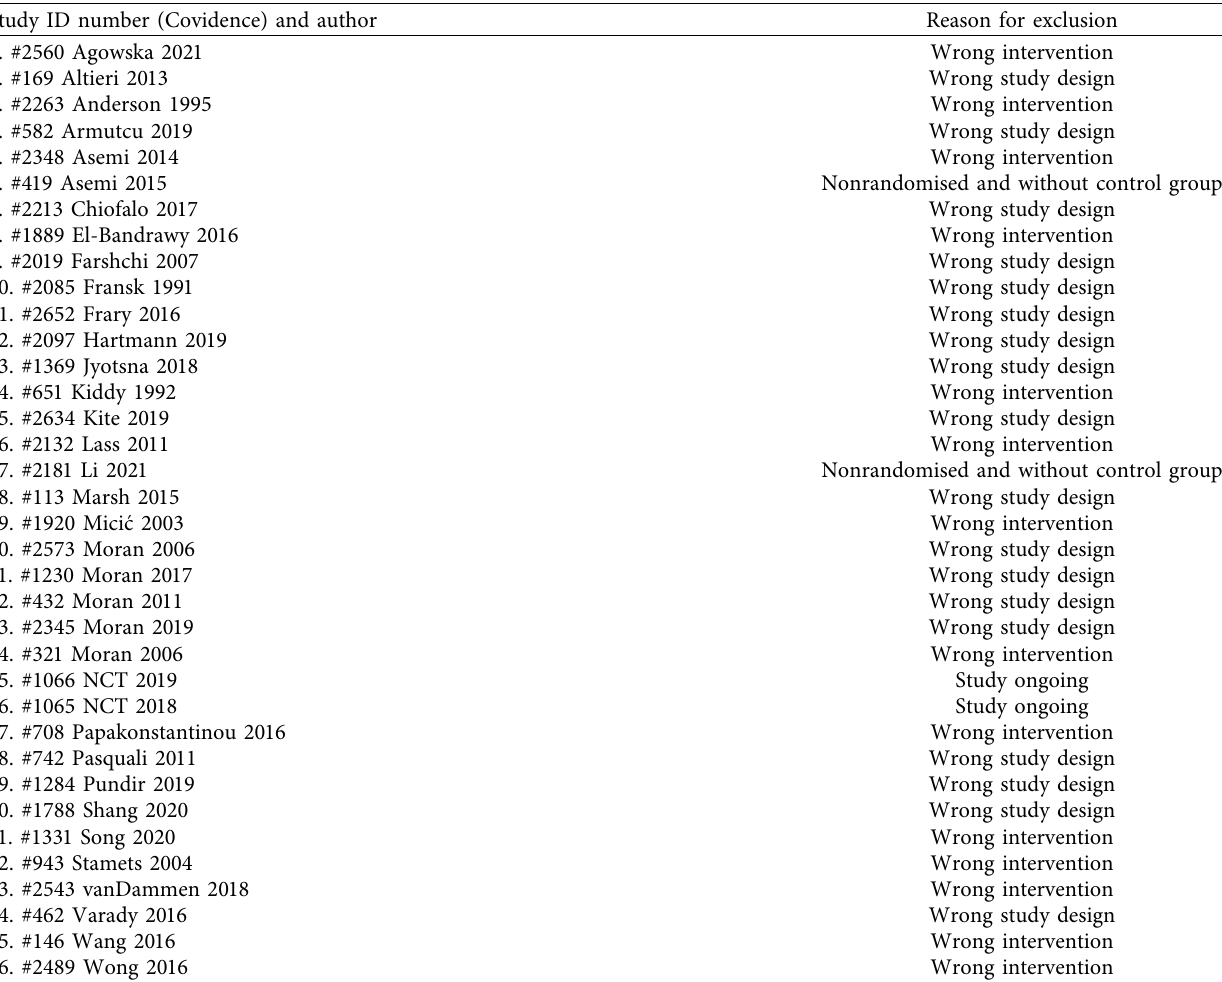
Table 2: Excluded studies after full text